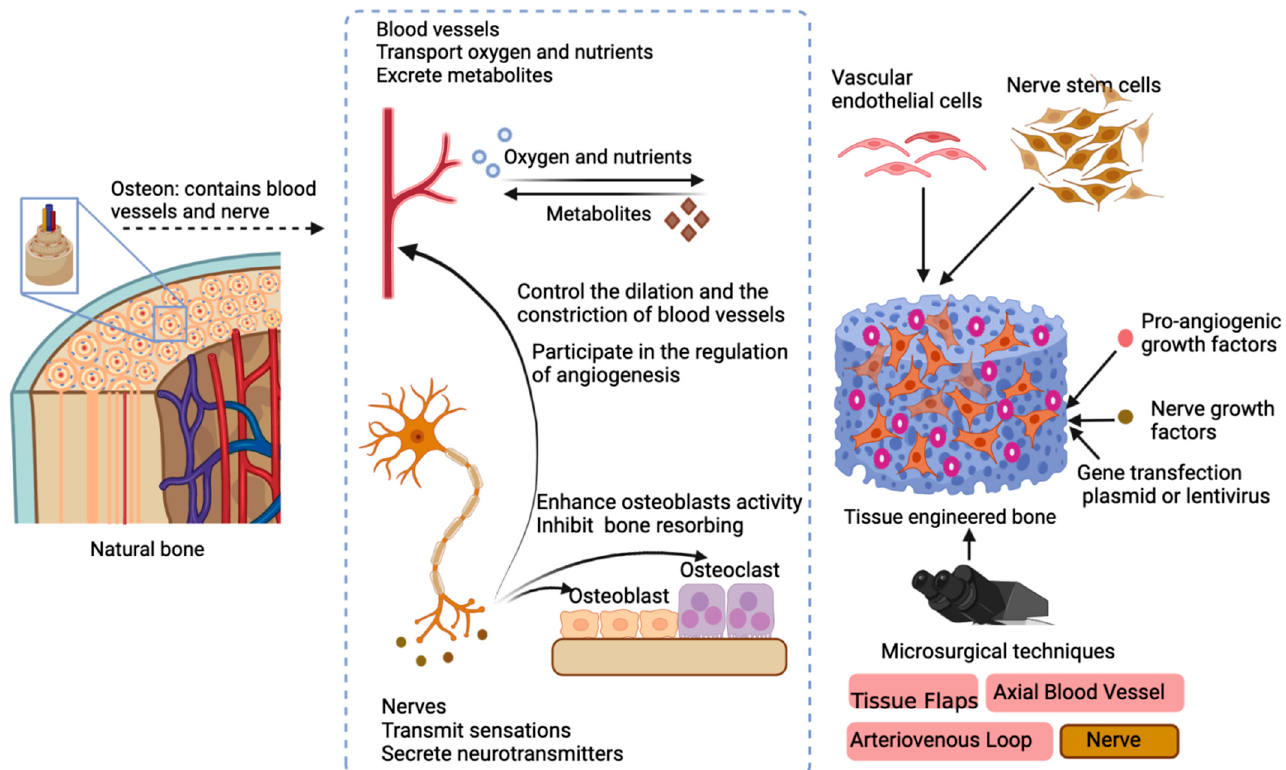
Figure 4. Vascularization and neuralization of tissue-engineered bone. Natural bone contains blood vessels and nerves. Blood vessels can transport oxygen, nutrients, and metabolites, which is very important for the proliferation and differentiation of seed cells in tissue-engineered bone. Nerves can transmit sensations and secrete neurotransmitters. Tissue-engineered bone can possess sensation, which makes it more bionic. Neurotransmitters can regulate the activity of osteoblasts and osteoclasts to maintain bone homeostasis. It can also regulate the constriction and relaxation of blood vessels, which are mainly determined by the type of blood vessels. Neurotransmitters are involved in regulating the regeneration of blood vessels. The current strategies for vascularization and neuralization of tissue-engineered bones mainly include: loading vascular endothelial cells and neural stem cells; loading angiogenesis factors and nerve growth factors, which can also be transfected into cells by transfecting gene coding; implanting blood vessels, nerves, and other tissues through